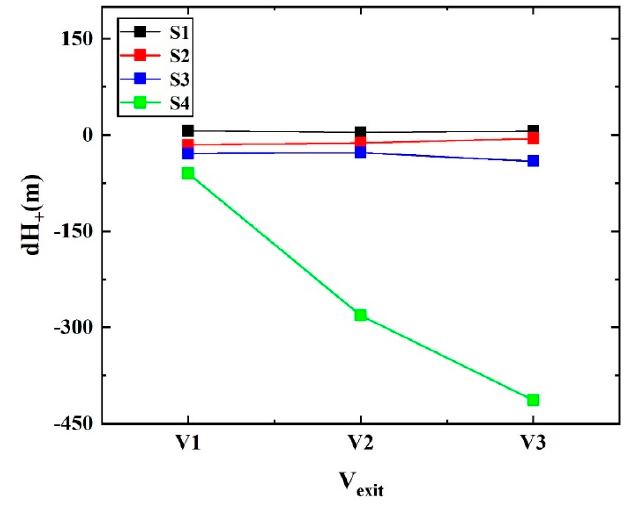
Figure 6. The rising height difference (dH + ) between the moving source scheme and the stationary source scheme at different emission levels in the T2 scenario with a wind speed of 3 m/s.